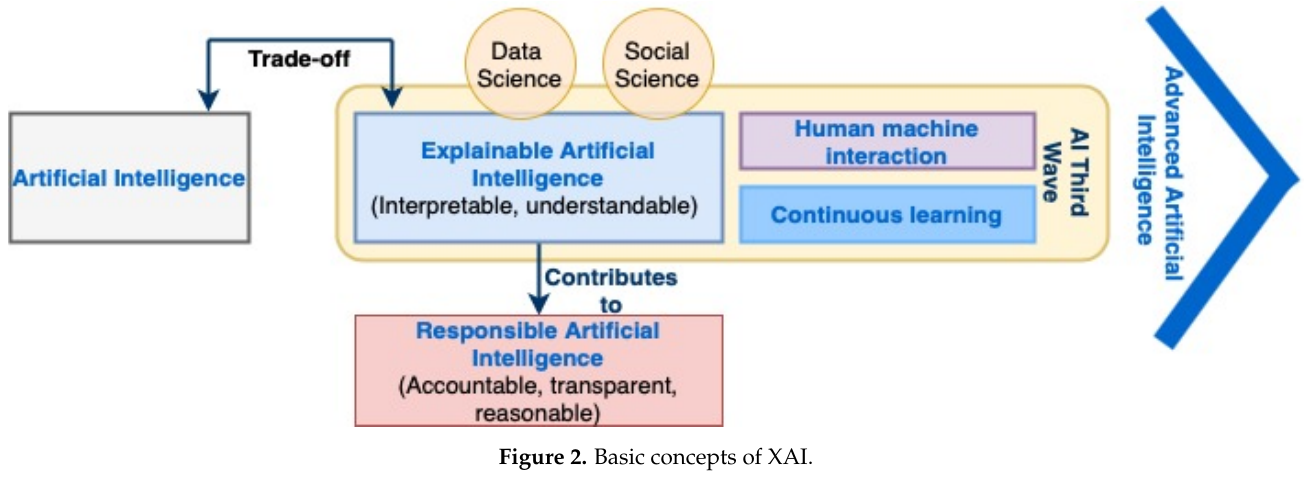
Figure 2. Basic concepts of